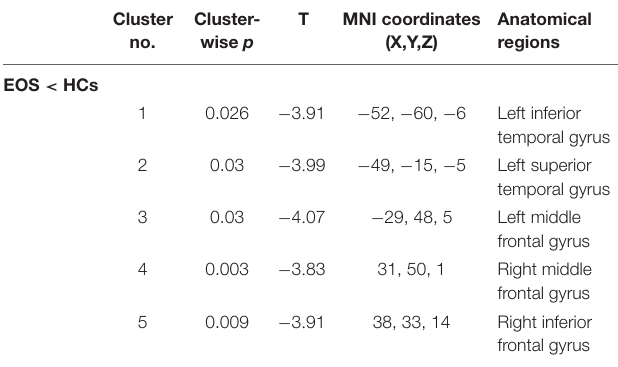
TABLE 4 | Reduced cortical thickness between the comparison of the early-onset schizophrenia (EOS) and healthy controls (HCs) groups. Cluster MNI coordinates no.